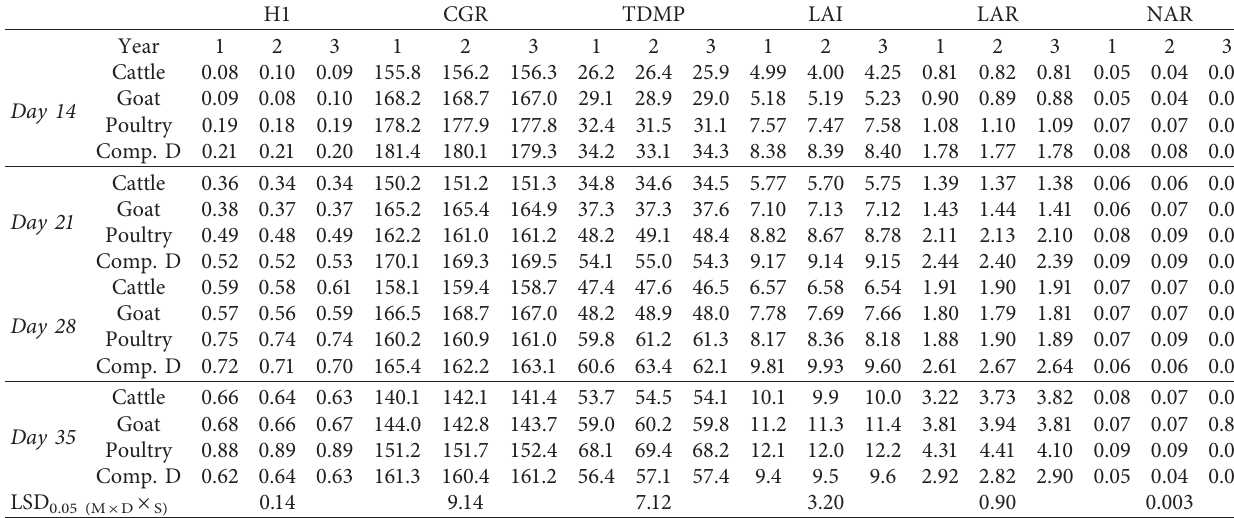
Table 4: Effects of type of organic source × days after fertilizer application × growing season on the baby spinach the growth parameters. H1 CGR TDMP LAI LAR